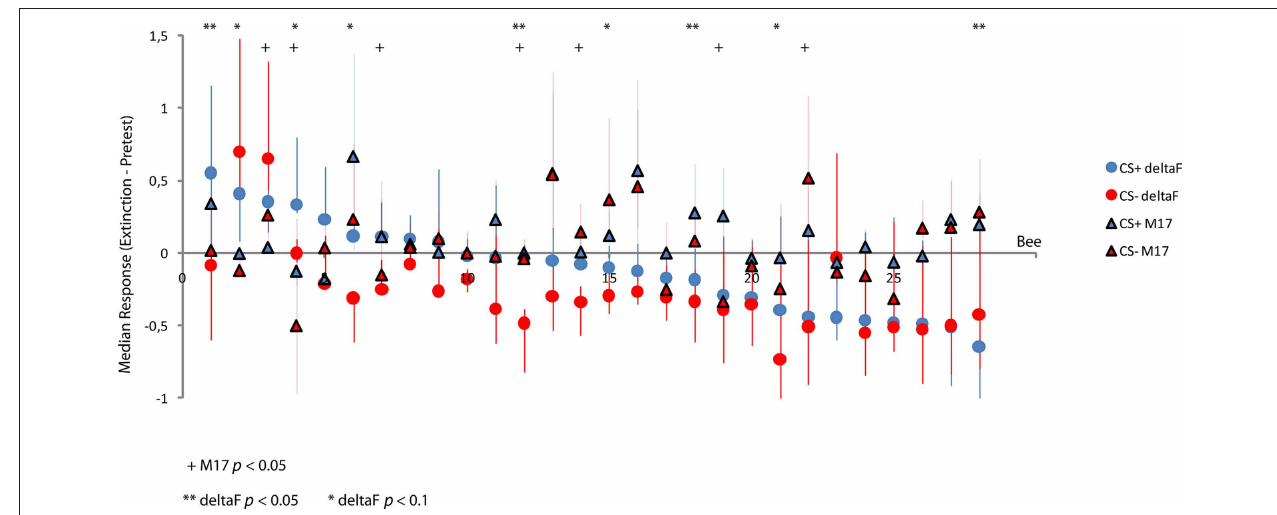
FiGure 6 | Calcium responses and M17 responses of individual bees. Signals were normalized to the maximum response in each odor and bee. For each bee the pretest responses were subtracted from the responses during the extinction test. Plotted are the medians of the six resulting values for each bee for the CS + and CS − . Error bars represent the 25% quartile range. Data